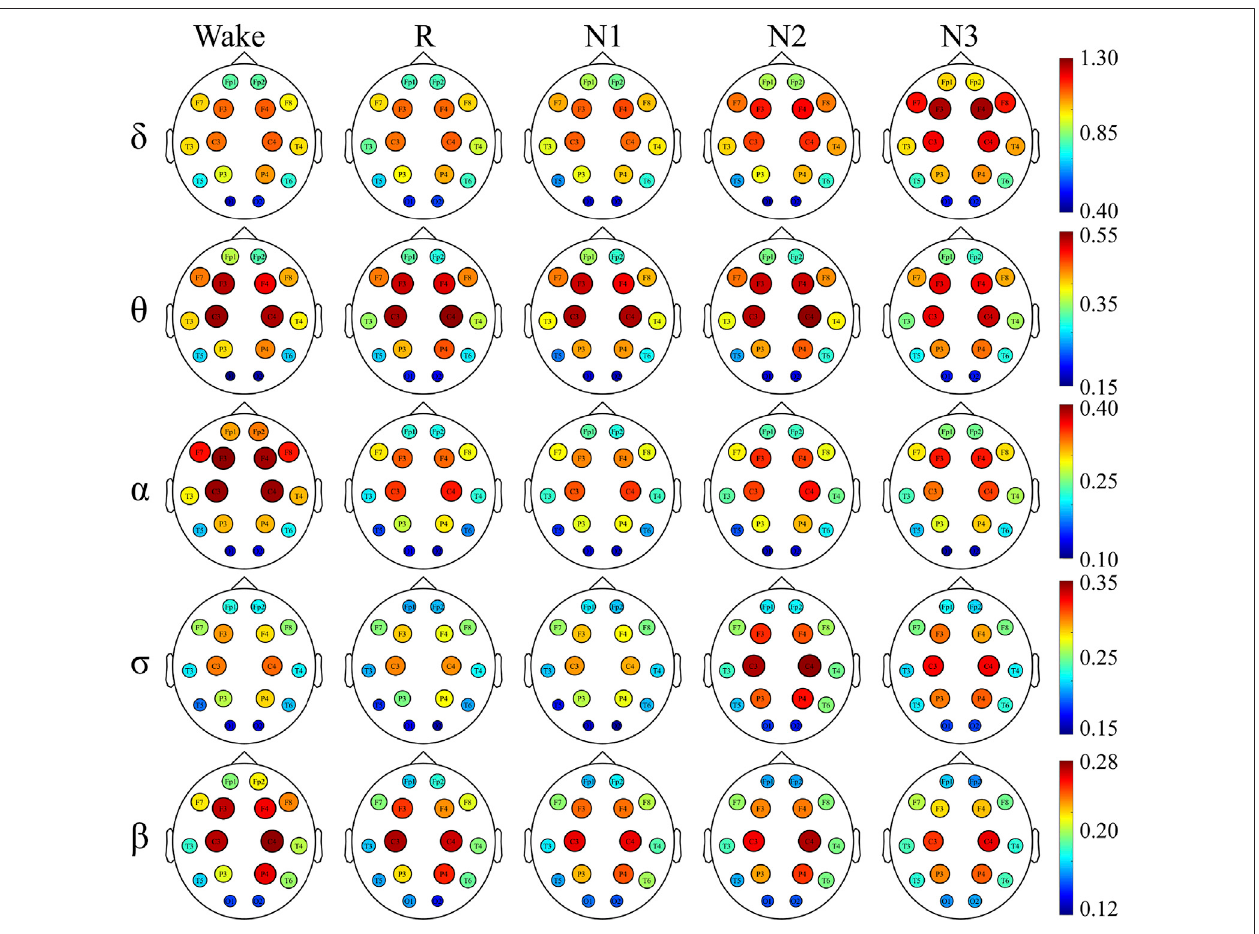
FIGURE 4 | Node strength of the depressed group and red indicates a higher node